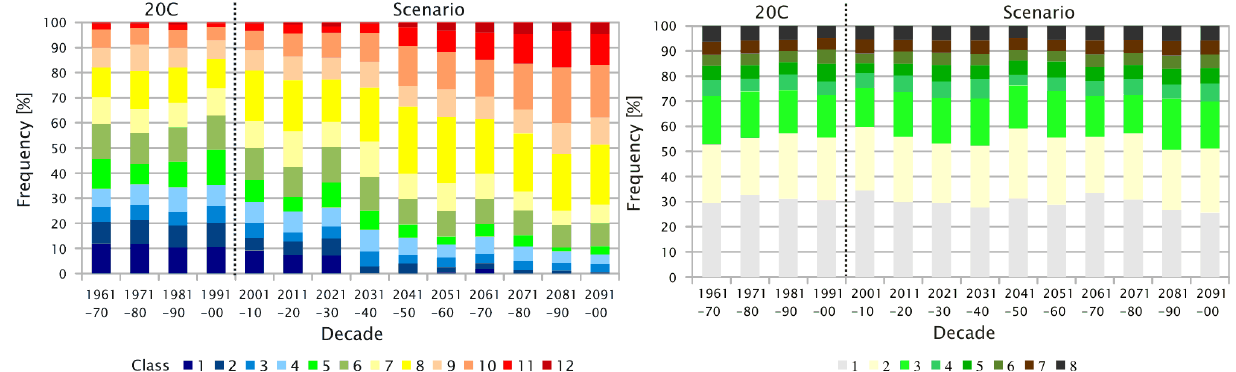
Figure 3. Example for the temporal development of the frequencies of 12 WETTREG temperature patterns (left) and eight precipitation patterns (right), as they are re-identified in a model run by ECHAM5/MPI-OM T63L31 run 1 [46,47]. 1961–2000: ECHAM5 forced by 20C data. 2001–2100: ECHAM5 forced by SRES scenario A1B data. Region: Saxony. Season: